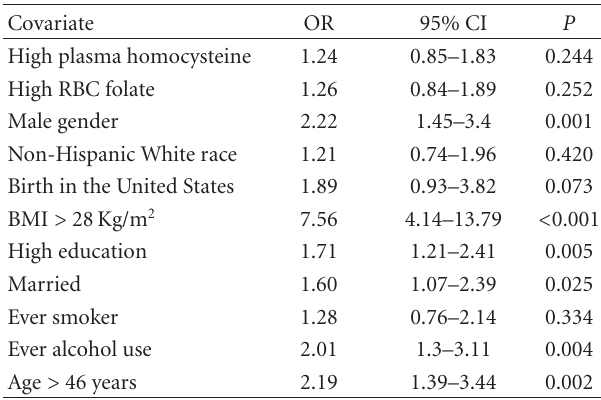
Table 3: Results from the full multivariate logistic regression analysis (Model 18 in Figure 3) for the outcome of self-reported sleep